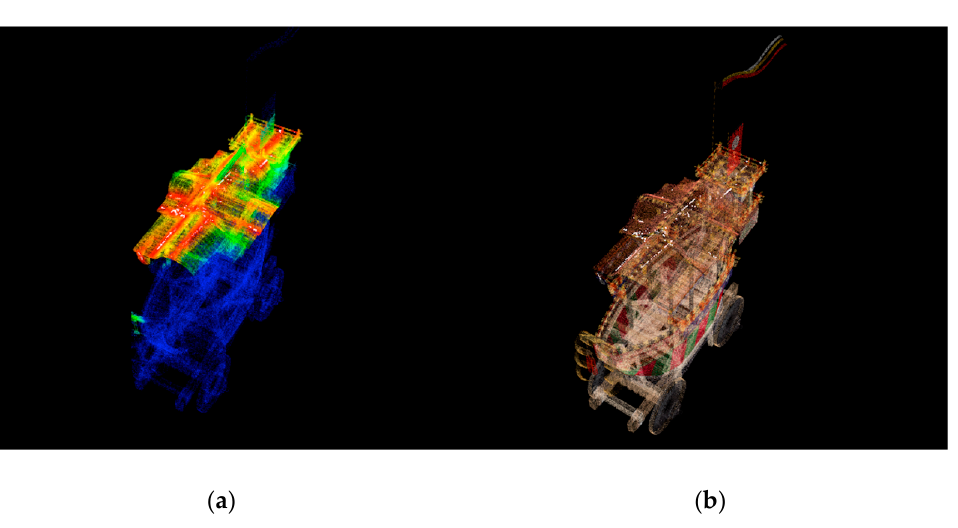
Figure 12. Transparent collision visualization similar to Figure 8. Only the collision areas of the Ofune- hoko float are given the white highlighted color.